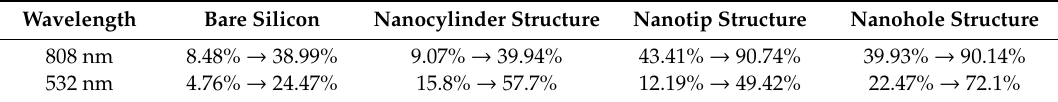
Table 4. The frequency-averaged modulation depths of the four models from 10 to 60 mW / mm 2.